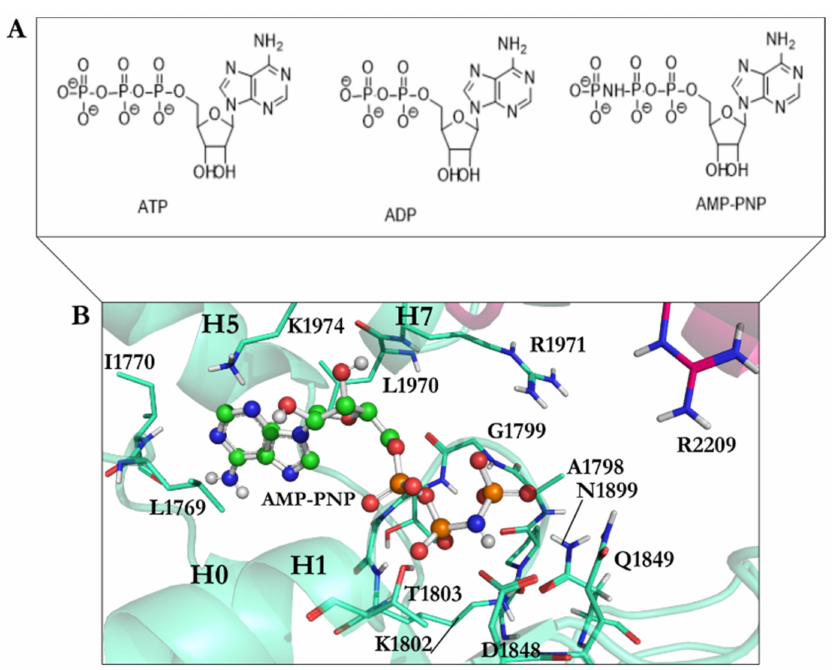
Figure 3. ( A ) The chemical structures of ATP, ADP, and AMPPNP; ( B ) AMPPNP in the ball-and-stick representation (green) interacts with amino acids in the AAA1 binding site of cytoplasmic dynein 1. Color code: AAA1 in cyan blue and AAA2 in sharp